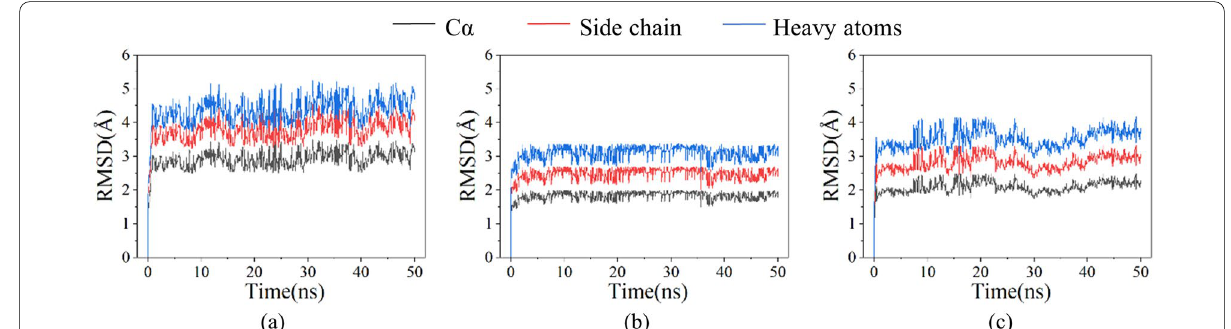
Fig. 1 Comparison and analysis of differences between F- Bb AmDH, L- Bc AmDH and cFLF-AmDH based on MD simulation. The above plot shows the RMSD evolution of F- Bb AmDH ( a ), L- Bc AmDH ( b ) and cFLF-AmDH ( c ) during the 50-ns simulation at 300 K and 1.01 bar pressure. The first frame is used as the reference. All protein frames are first aligned on the reference frame backbone, and then the RMSD of Cα (black), side chain (red), and heavy atoms (blue) were